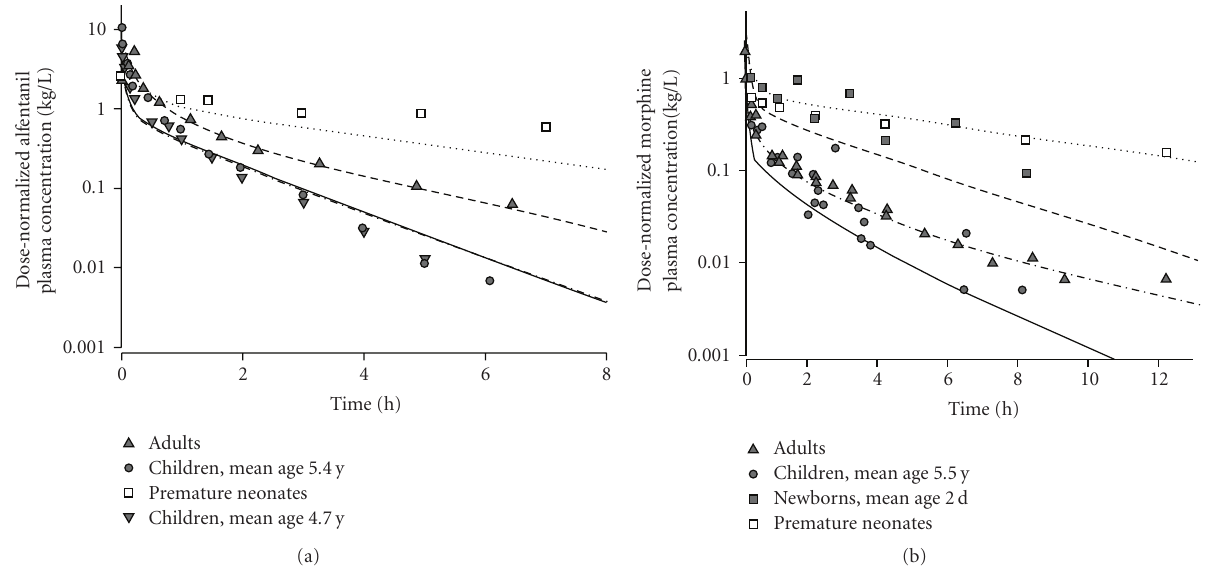
Figure 6: Predicted dose-normalized pediatric plasma concentration-time curves (lines) versus observed data (symbols) for (a) alfentanil and (b) morphine as reported in the original study by Edginton et al. [52]. Observed data was obtained from various studies in the